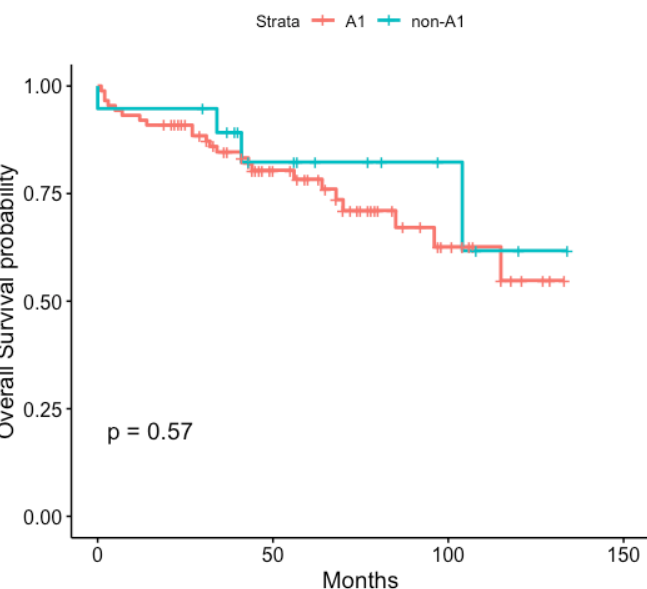
Figure 2. Kaplan-Meier survival curve stratified by HPV 16 sub-lineages (A1 vs. Non-A1). Survival time expressed in months from the diagnosis date. Data censored on 31 July 2020.